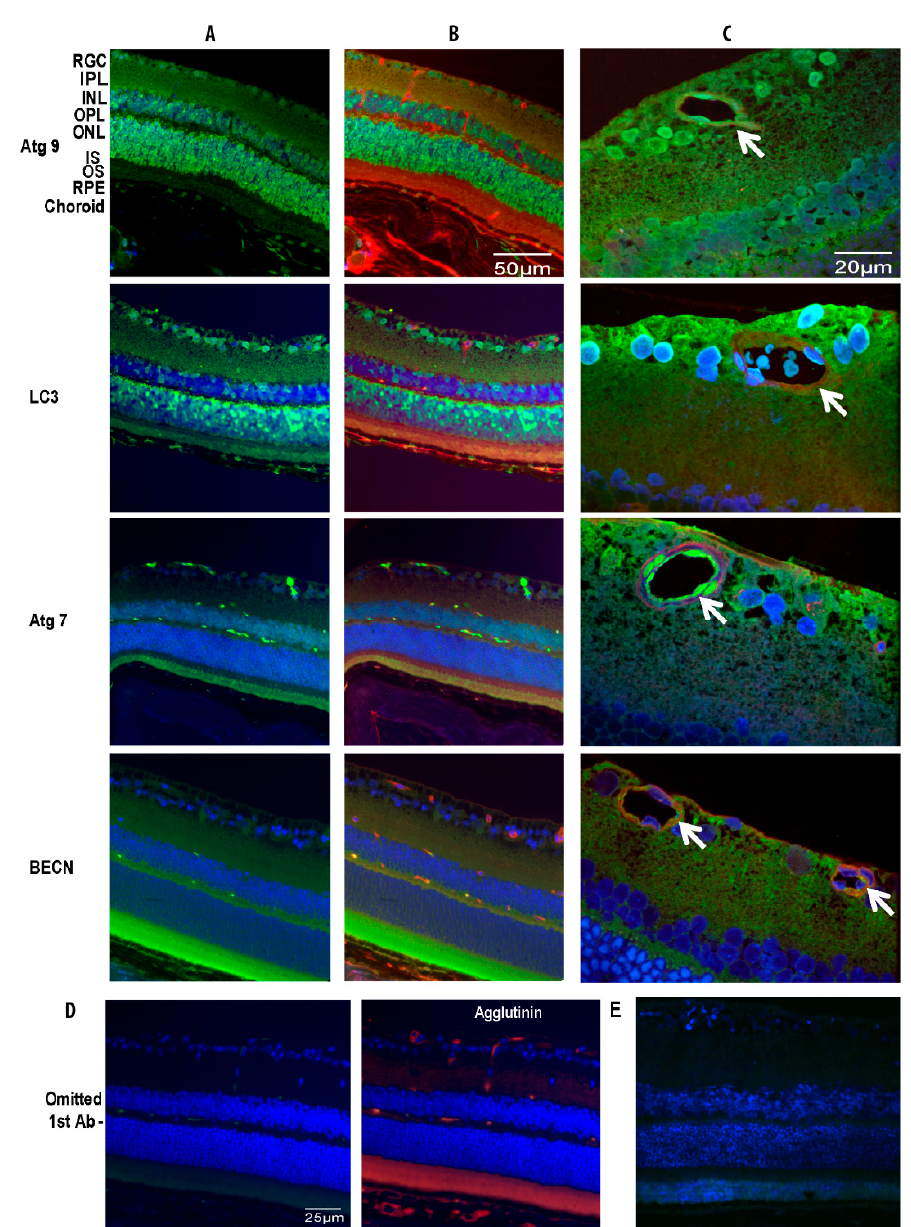
( C , D ). Atg7 and Beclin1 (BECN) expressions ( E , F ) were on a monophasic 24 h cycle. Atg7 expression peaked at 8:15 AM and lowest levels were at 10:15AM. The peak of Beclin1 expression was at midnight and lowest levels were observed during the late morning ( H ). All animals were maintained in a standard 12/12 h light/dark phase with lights ON at 6:00AM and lights OFF at 6:00PM. The error bars in the diurnal plots represent the mean+SEM and diurnal oscillation had a p -value less than 0.05.